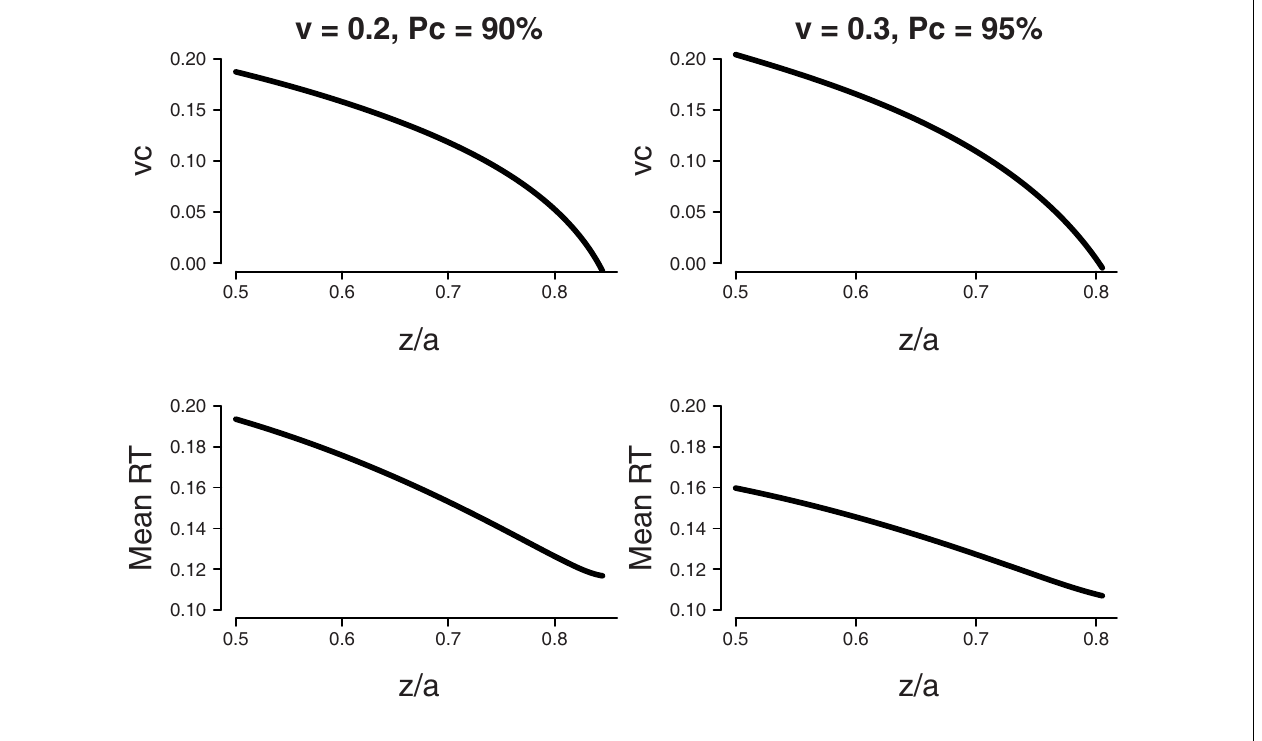
separation z / a and shift in drift rate criterion v c that lead to the same fixed level of accuracy (90% for v = 0.2, 95% for v = 0.3). Bottom panel: Mean RT that corresponds to the parameter combinations of the top